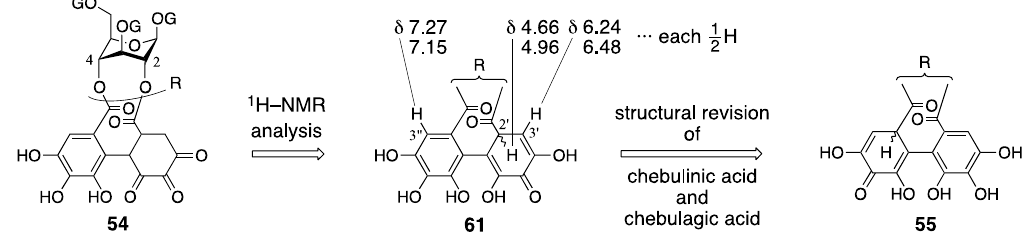
Figure 25. The pathway of the structural revision to 55 .